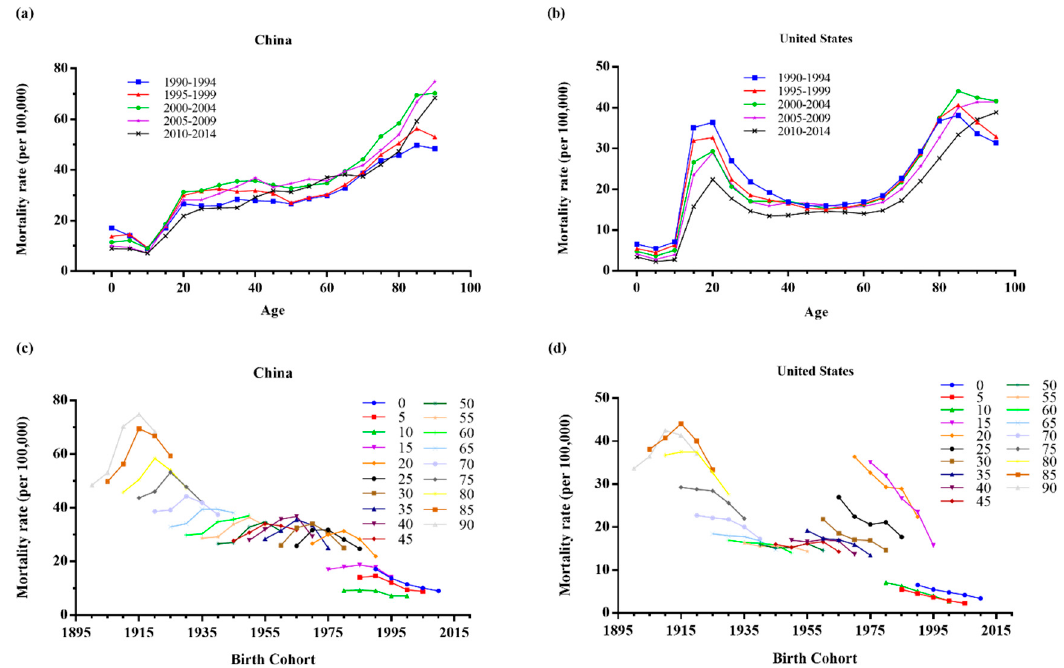
Figure 2. Age-specific mortality rates of road injuries by periods and cohort-specific mortality rates of road injuries by age groups in China and the United States. ( a , b ) represented the age-specific mortality; ( c , d ) represent the cohort-specific mortality.